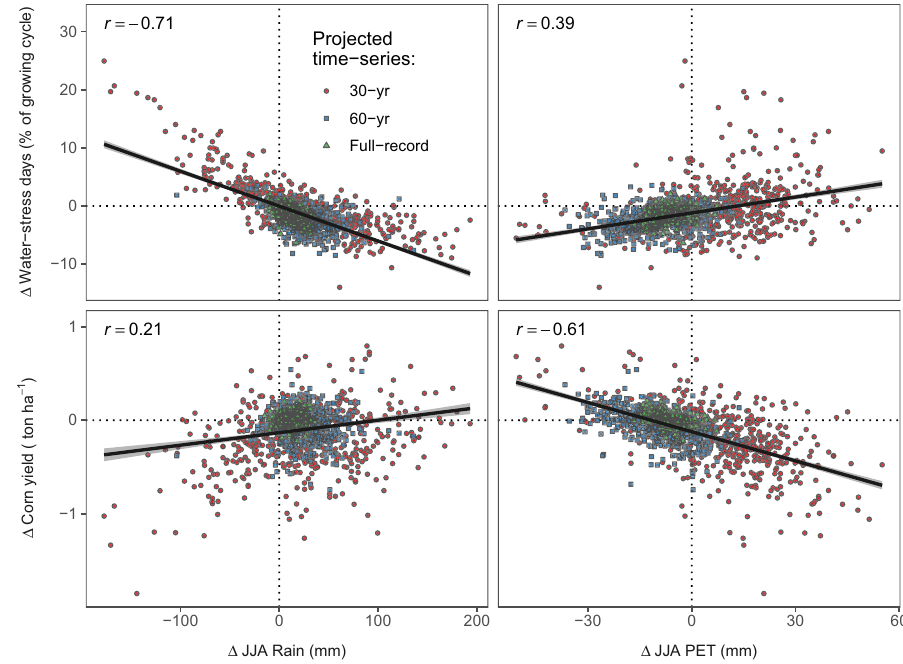
Fig. 6 Correlation of changes in summer rainfall and potential evapotranspiration (PET) to changes in corn water-stress days and yields under projected climatic changes. Each symbol indicates the average value of the simulation at a weather station with a given time series. r = coef fi cient of